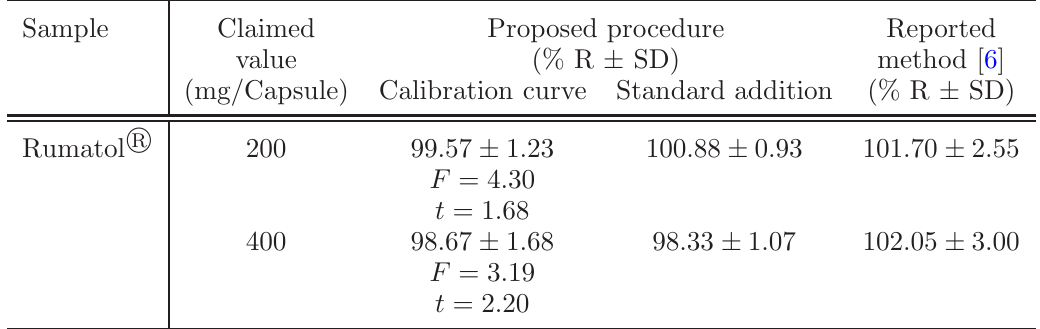
Table 3 Assay of tolmetin in pharmaceutical formulations by the proposed SW-AdCS voltammetric procedure and a reported micellar LC method [6].